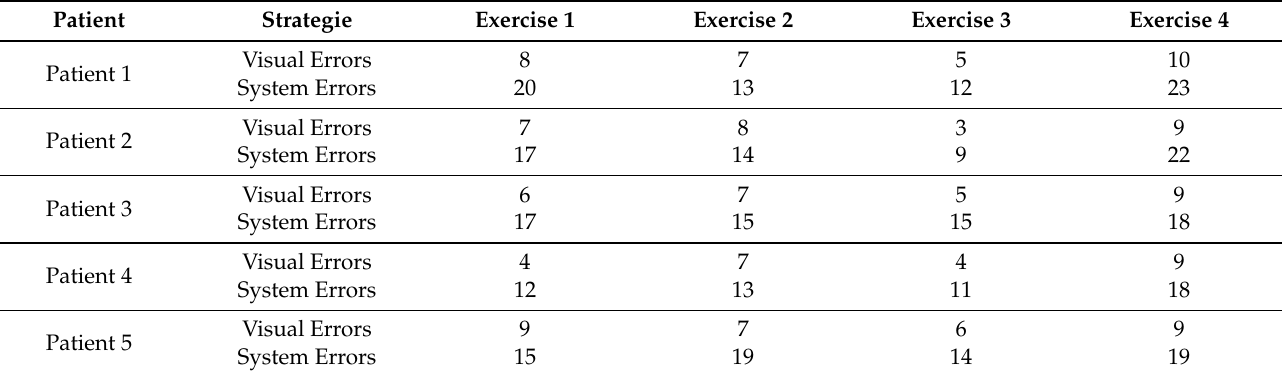
Table 2. Comparison between expert errors detected and system errors